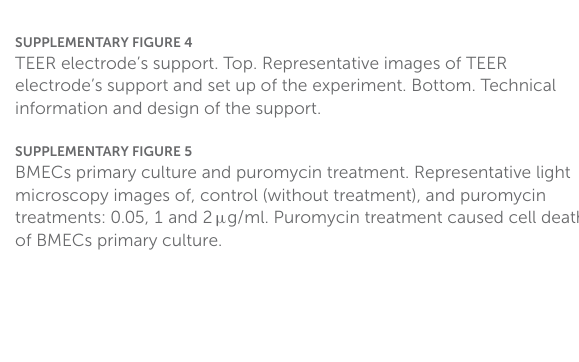
SUPPLEMENTARYFIGURE4 TEER electrode’s support. Top. Representative images of TEER electrode’s support and set up of the experiment. Bottom. Technical information and design of the